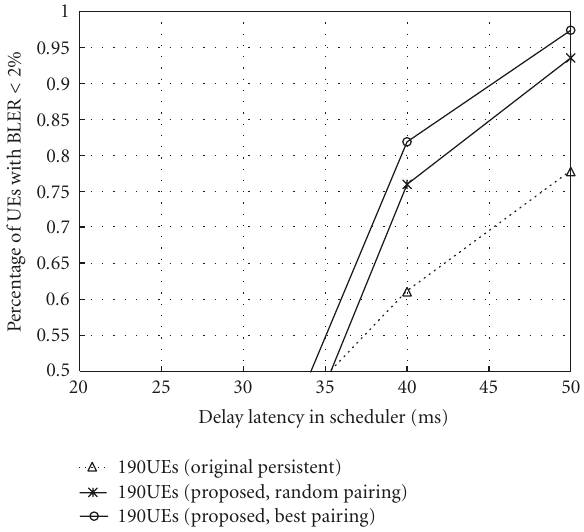
Figure 4: Outage probability versus delay latency in